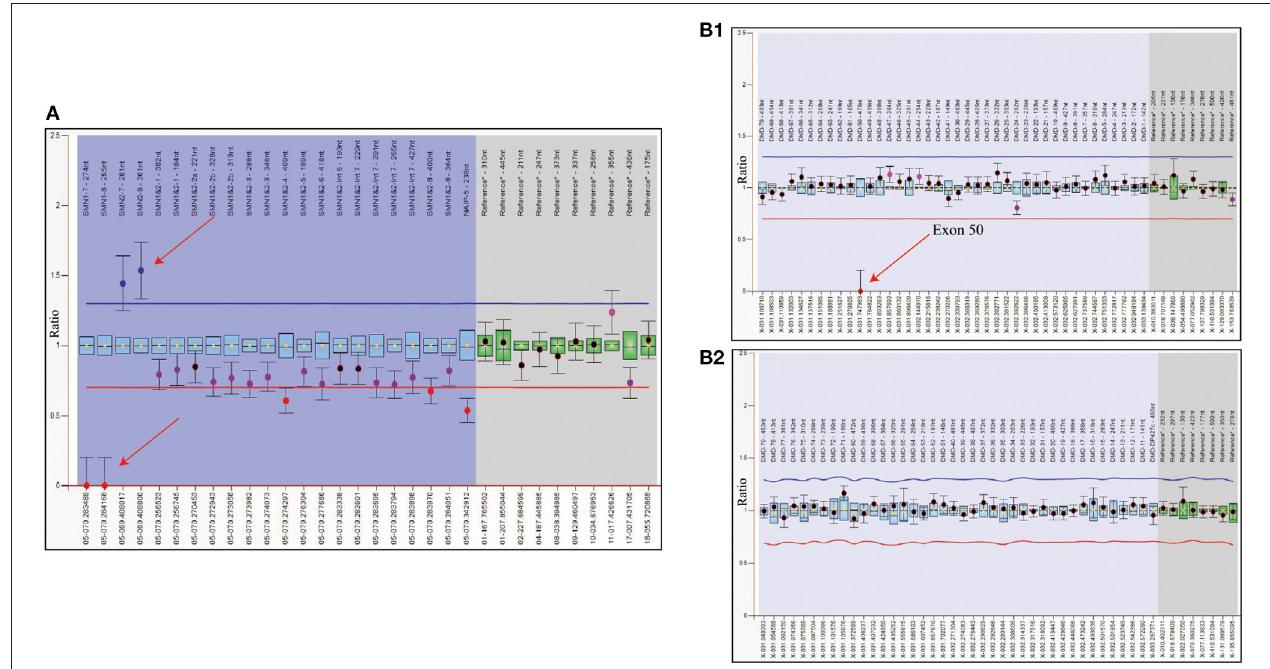
FIGURE 2 | WES analysis of patient showed the complete deletion of DMD gene exon 50. (A) Integrative genomics view of patient’s Xp21.1, compared with a normal reference sample. (B) IGV enlarged image of DMD gene exon 50 confirmed the